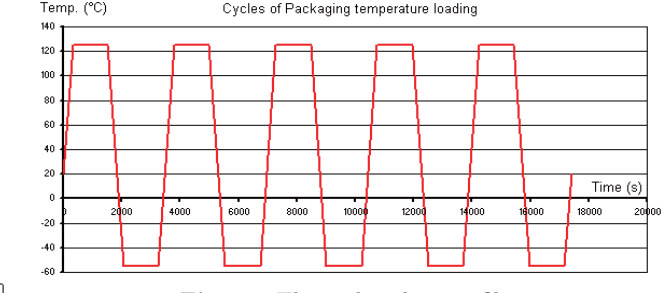
Fig. 13. Thermal cycling profile.